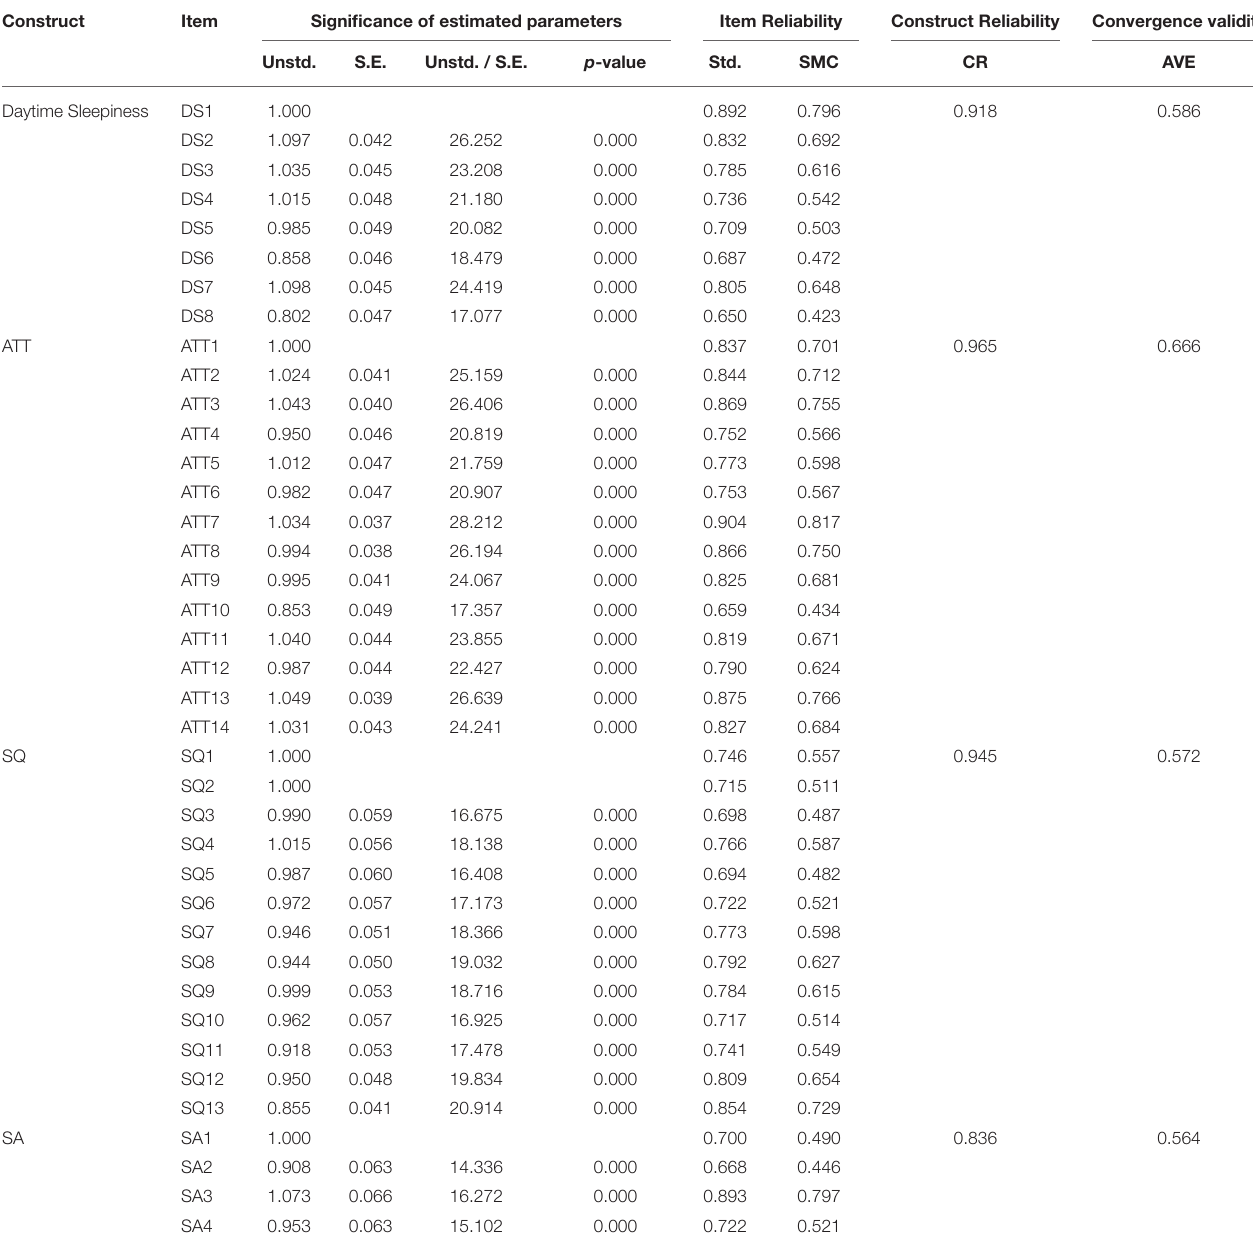
TABLE 4 | Results for the measurement